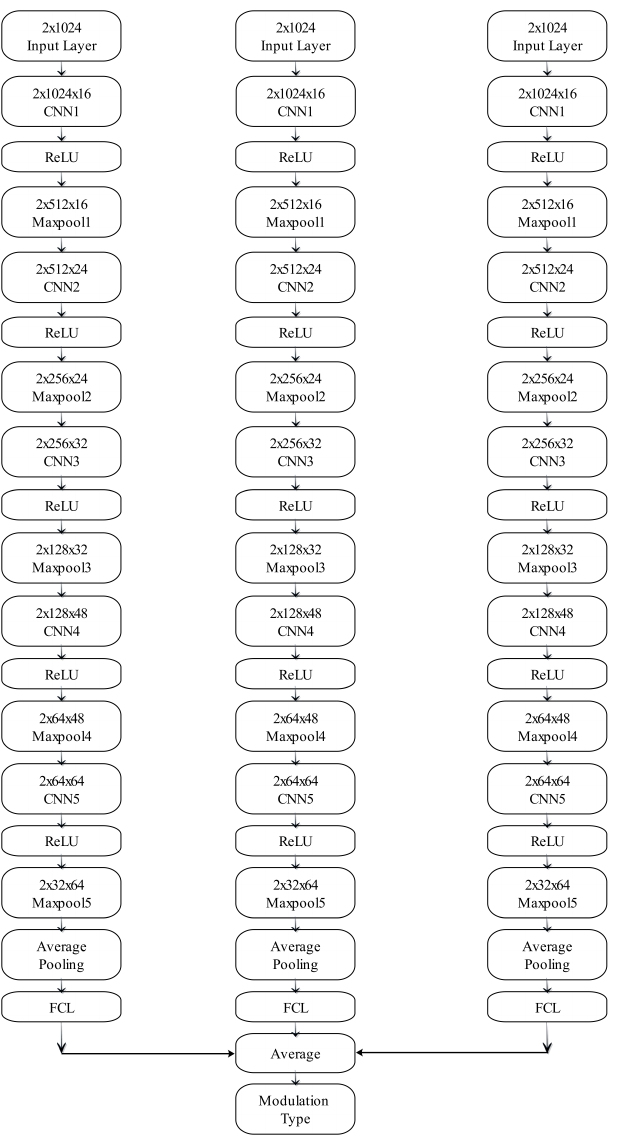
Figure 2. Proposed Deep Convolutional Neural Network Layers